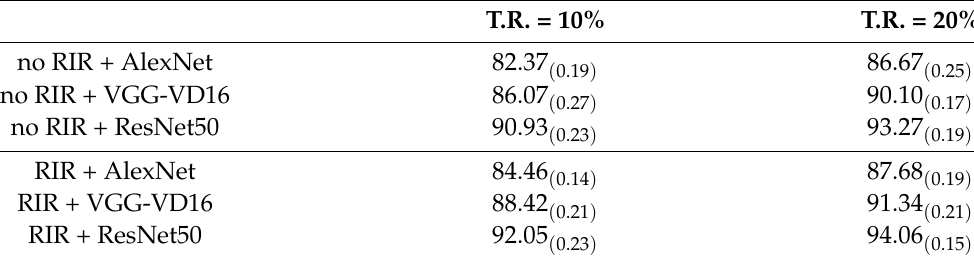
Table 5. Classification accuracies (%) on the NWPU data set.